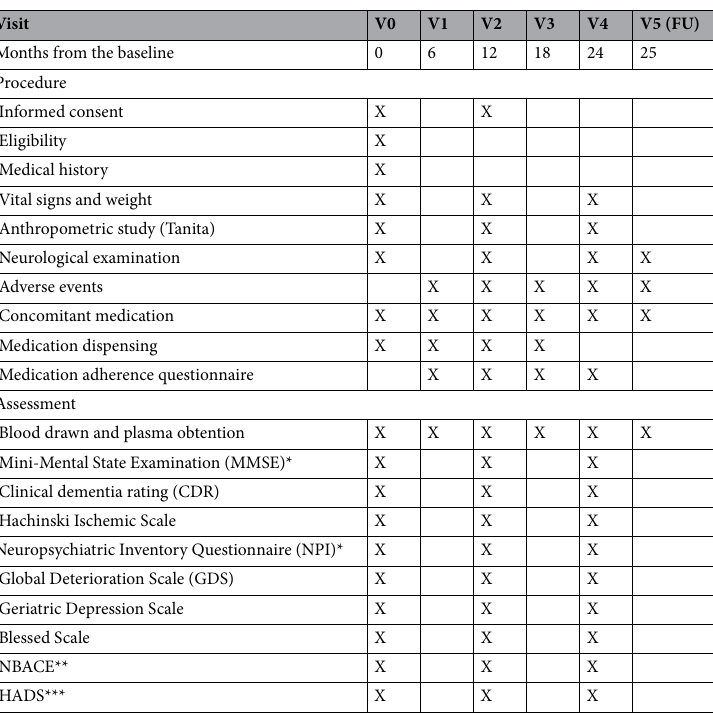
Table 1. Data collection and procedures per study visit. *Spanish version; **Fundació ACE Neuropsychological Battery; ***HADS: the Spanish version of Hospital Anxiety and Depression Scale. FU